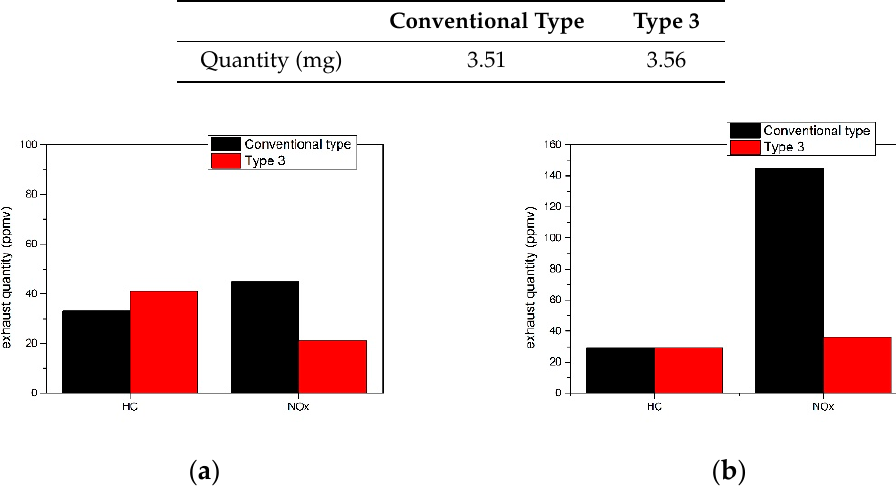
Figure 19. Comparison of HC and NO x emissions between conventional type and Type 3 DPI; ( a ) 7 mg/stroke (injection quantity) and BTDC 10 CA (injection timing); ( b ) 3, 7 mg/stroke (pilot/main injection quantity) and BTDC 15, 5 CA (pilot/main injection timing).